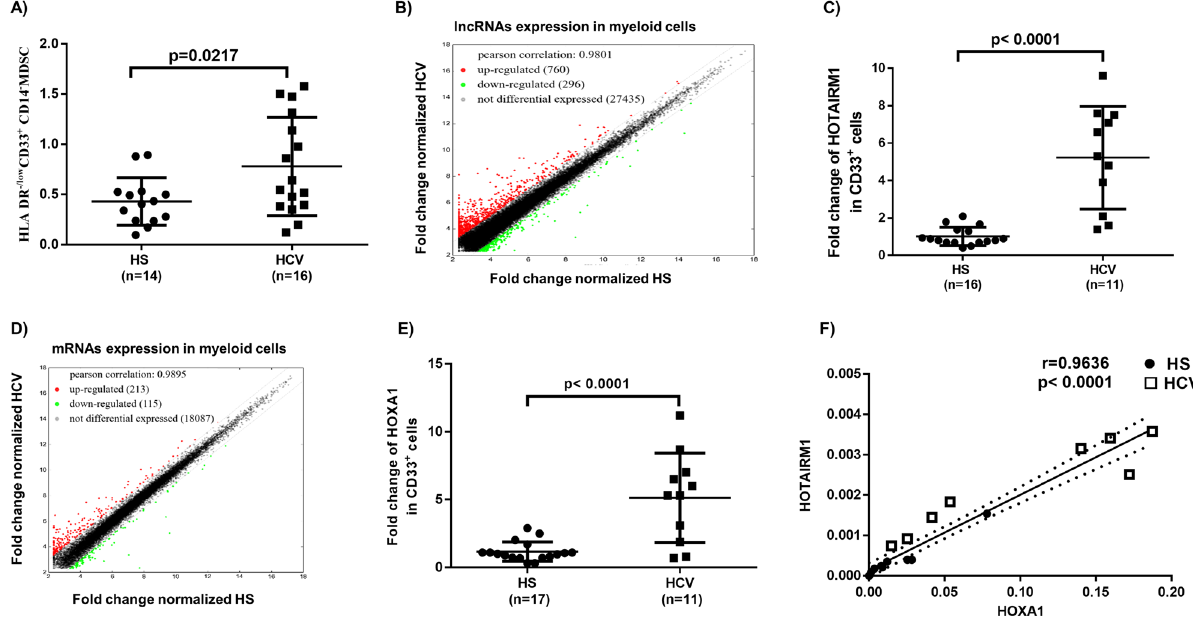
Figure 1. HOTAIRM1 and HOXA1 are upregulated in MDSCs in HCV-infected individuals. ( A ) Expansion of G-MDSCs (HLA-DR −/low CD33 + CD14 − cells) in PBMCs of HCV-infected individuals compared with HS, as determined by flow cytometry. ( B ) Scatter plot of the heat map of lncRNA expression in CD33 + cells isolated from HCV-infected individuals versus HS (n = 5 per group). ( C) HOTAIRM1 expression in CD33 + cells isolated from HCV-infected individuals versus HS, as determined by real-time RT-PCR. ( D ) Scatter plot of the heat map of mRNA expression in CD33 + cells isolated from HCV-infected individuals versus HS (n = 5 per group). ( E ) HOXA1 expression in CD33 + cells isolated from HCV-infected individuals versus HS, as determined by RT-PCR. ( F ) Pearson Correlation analysis of HOTAIRM1 and HOXA1 expression levels in CD33 + cells derived from the same